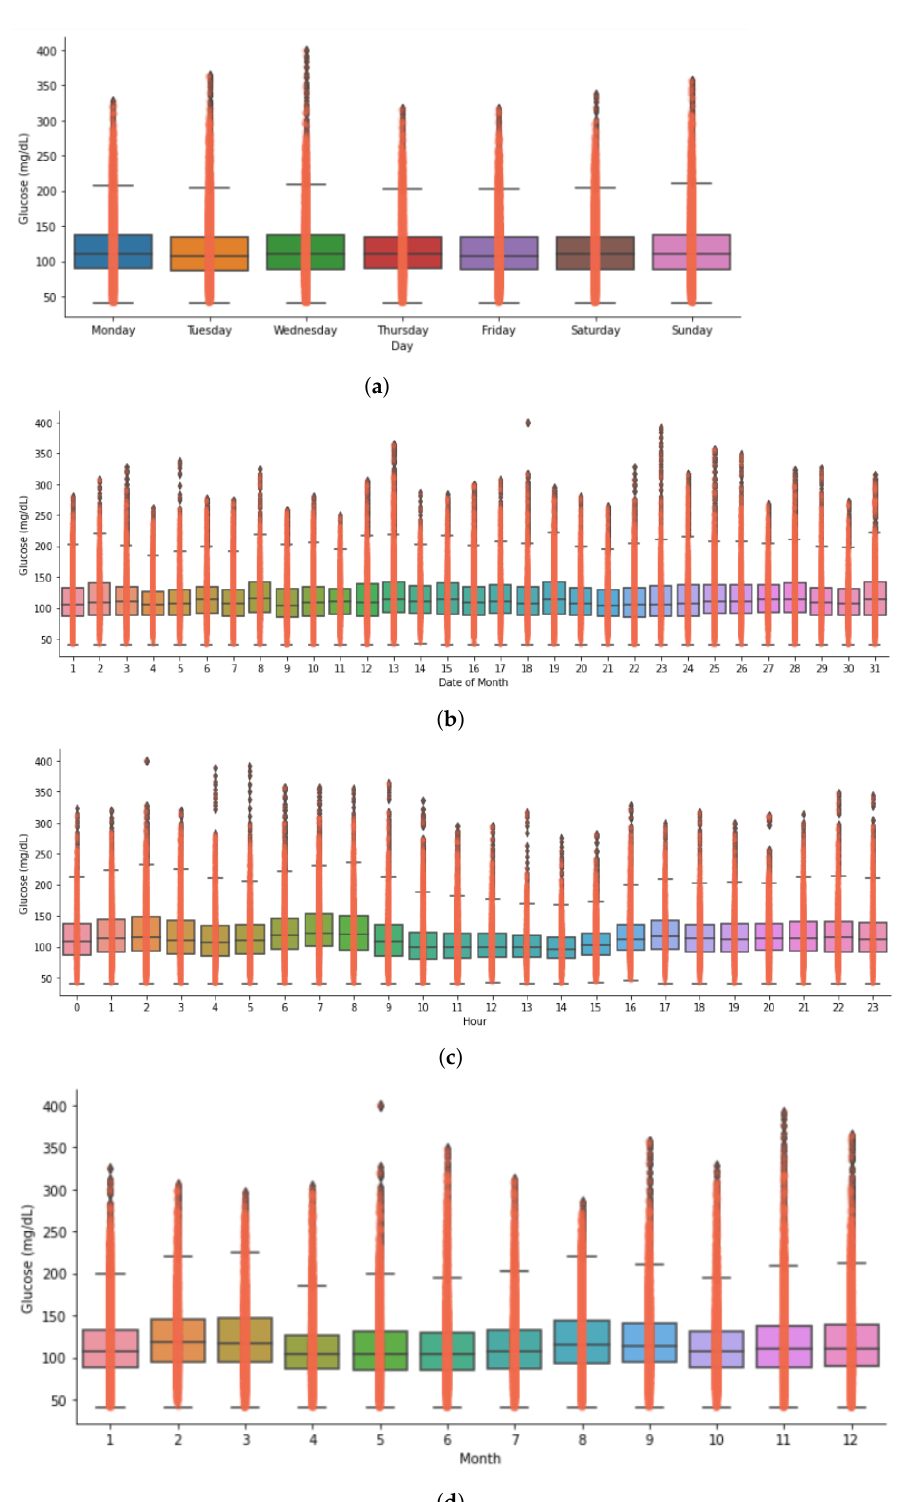
Figure A3. Timeseries analysis showing glucose distribution of an insulin-requiring individual using open-source AID during hours, week, days, and month. ( a ) Glucose distribution during the days of a week for an open-source AID user. ( b ) Glucose distribution during the days of a month for an open-source AID user. ( c ) Glucose distribution during the hours of a day for an open-source AID user. ( d ) Glucose distribution during the month of a year for an open-source AID